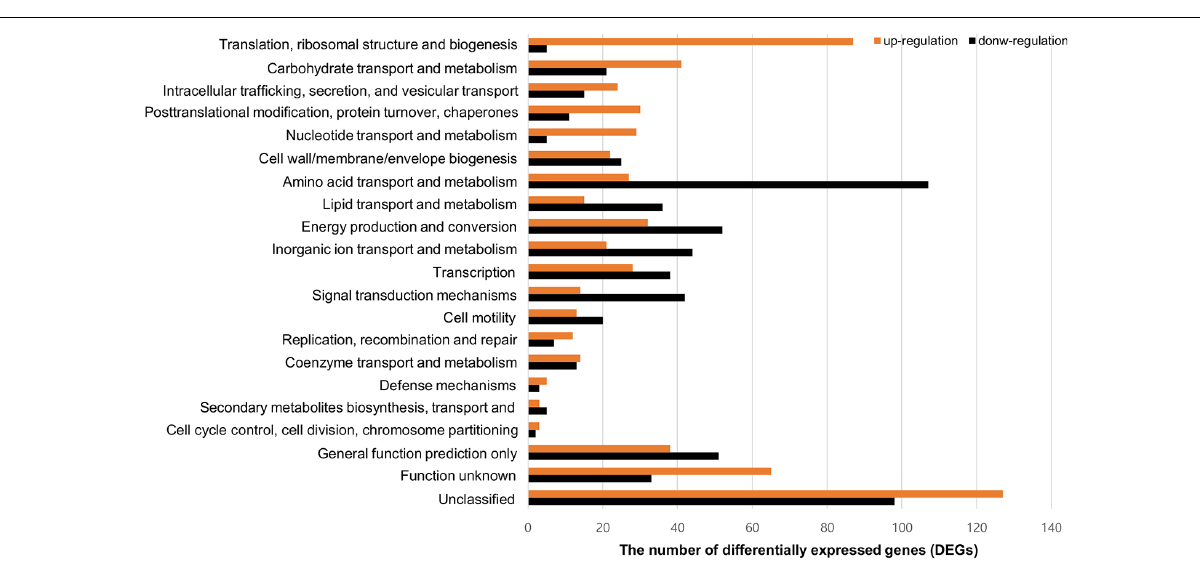
FIGURE 4 | Functional analysis of differentially expressed gene ( > 2-fold change) in the FORC_022 strain exposed to crabs. Functional categories were determined by the Clusters of Orthologous Groups (COG) database. Genes upregulated (orange) and downregulated (black) after exposure to crabs are